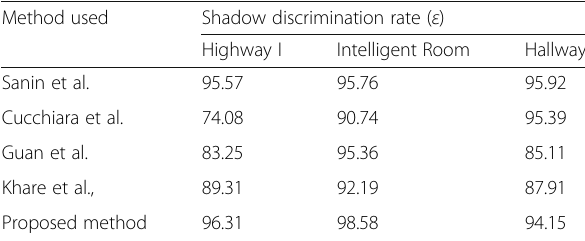
Table 2 Shadow discrimination rate ( ε ) for representative